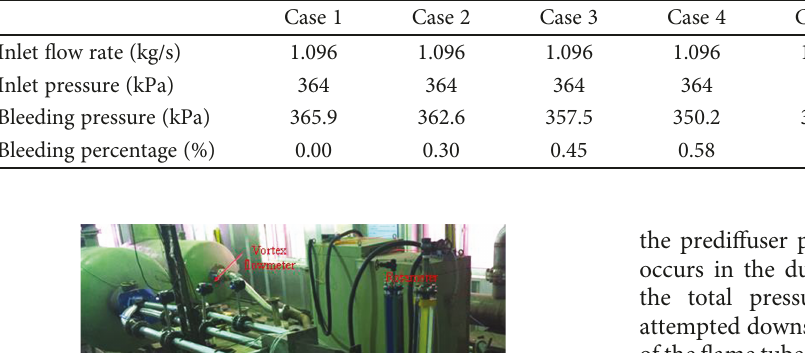
Table 4: Operating conditions ( H